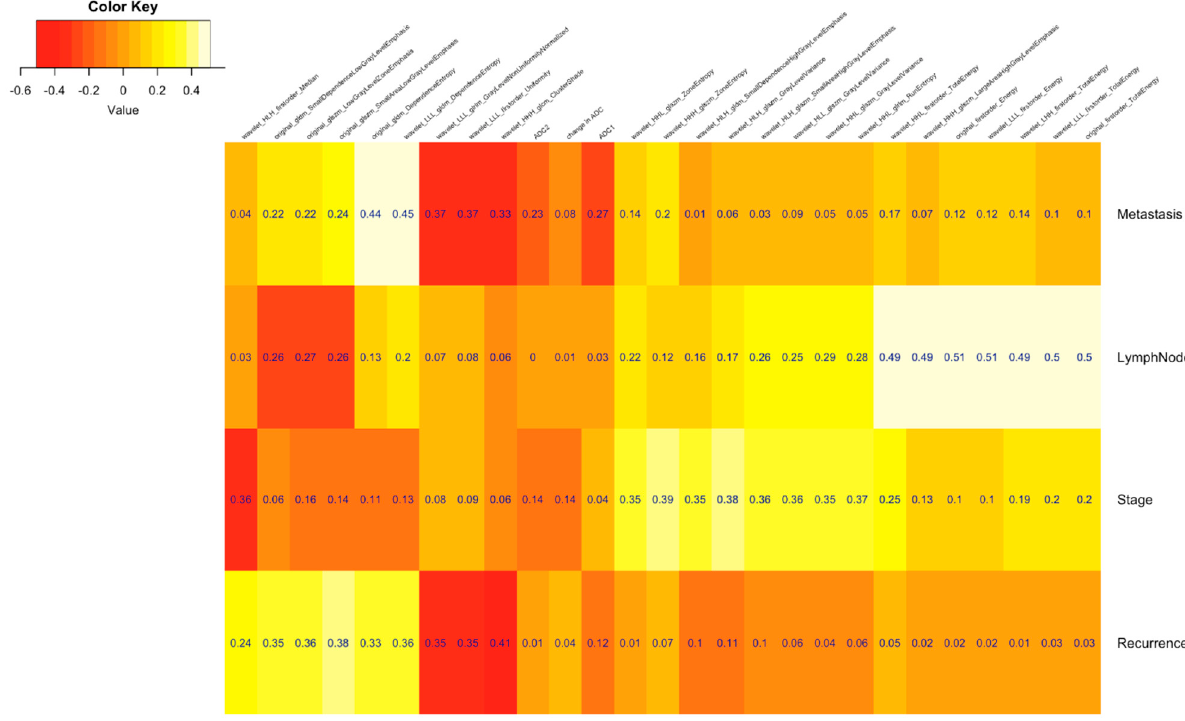
Figure 4. Heat map showing correlation between each feature with clinical outcomes desired in this study design.